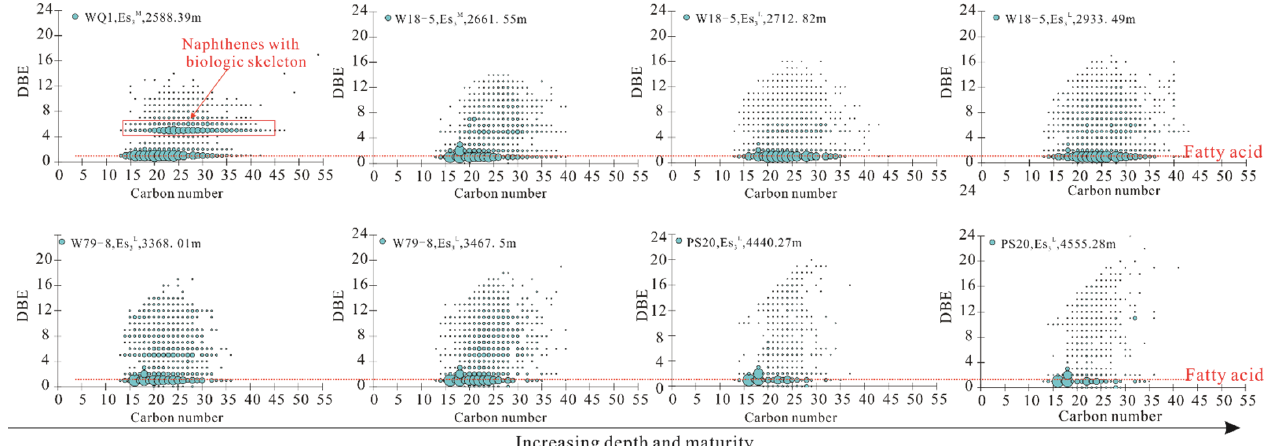
Figure 8. Relationship between the carbon numbers and DBE values of the analyzed samples detected by negative ion ESI FT-ICR MS with increasing depth and maturity. Class of DBE=1 of O 2 (fatty acids) are detected in the analyzed samples.